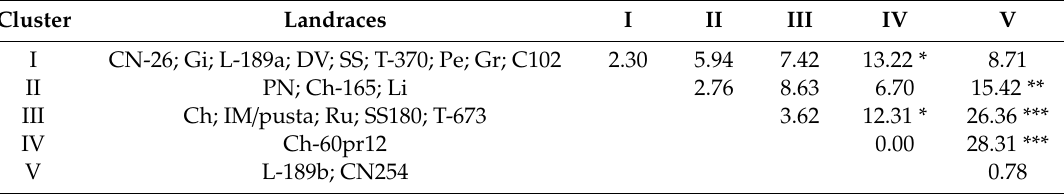
Table 5. Average intra- (bold diagonal) and inter-cluster (o ff diagonal) D2 values. Cluster Landraces